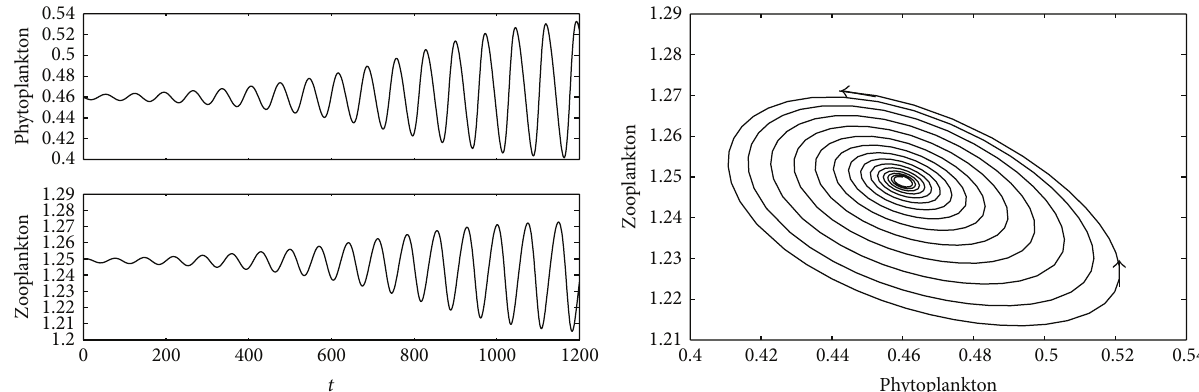
Figure 6: Behavior and phase portrait of system (4) with 𝜏 = 8 > 𝜏 0 . The interior equilibrium 𝐸 ∗ 12 is unstable. Here 𝜏 0 = 5.11 and the initial value is (𝜙(0),𝜑(0)) = (0.46, 1.25) .